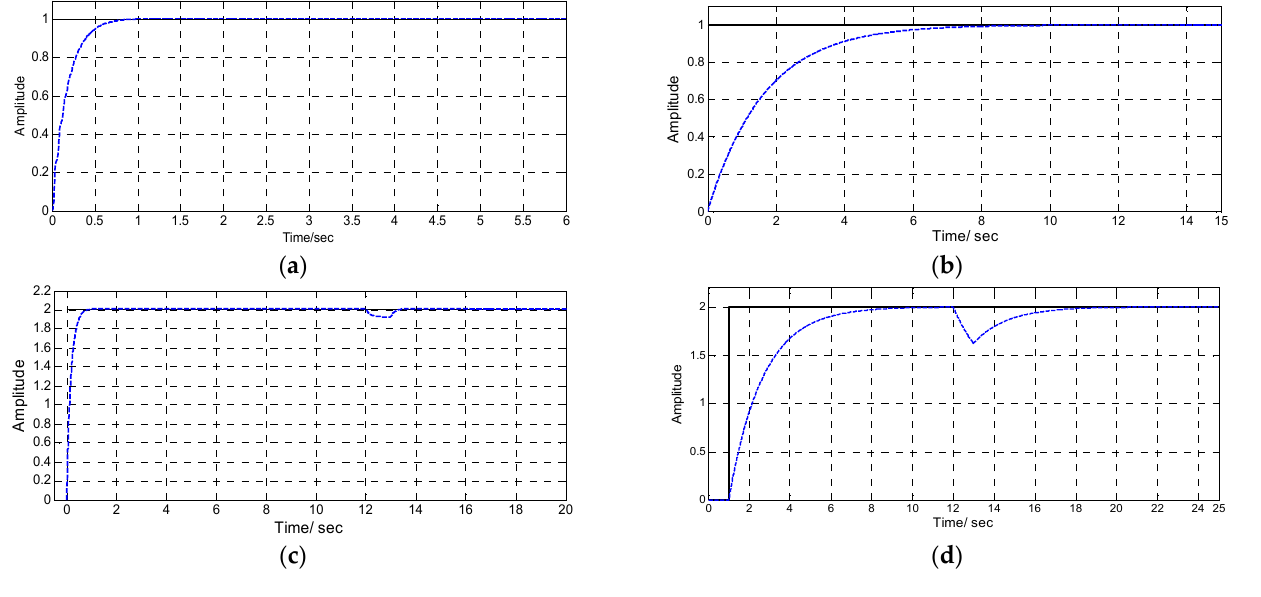
Figure 12. Response of the system to the unit step signal and response curve under the pulse